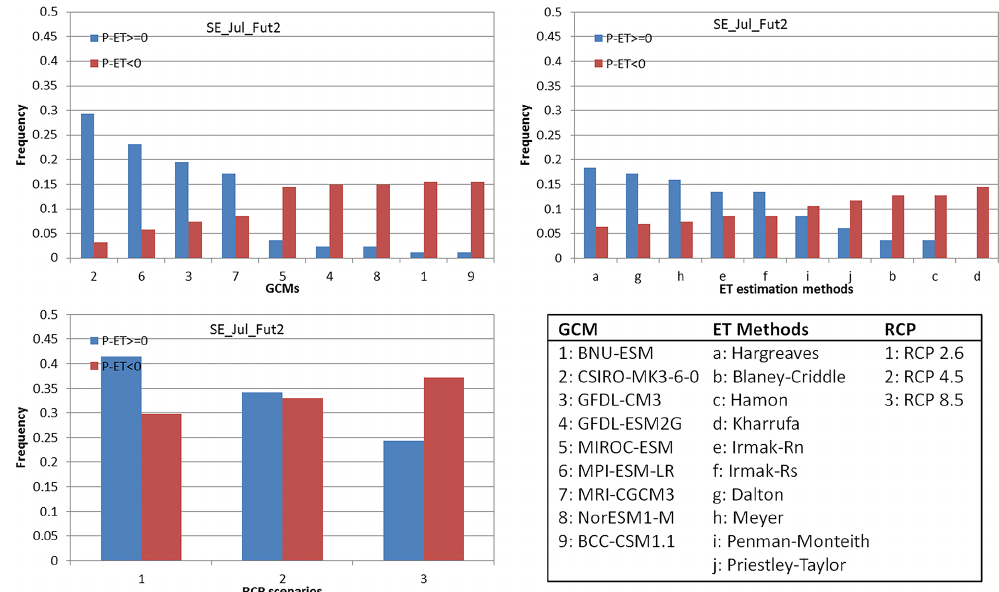
Figure 9. Histograms for projected future period 2 wet conditions and dry conditions in the Southeast US by GCMs, the ET 0 method, and RCP trajectory for the month of July.